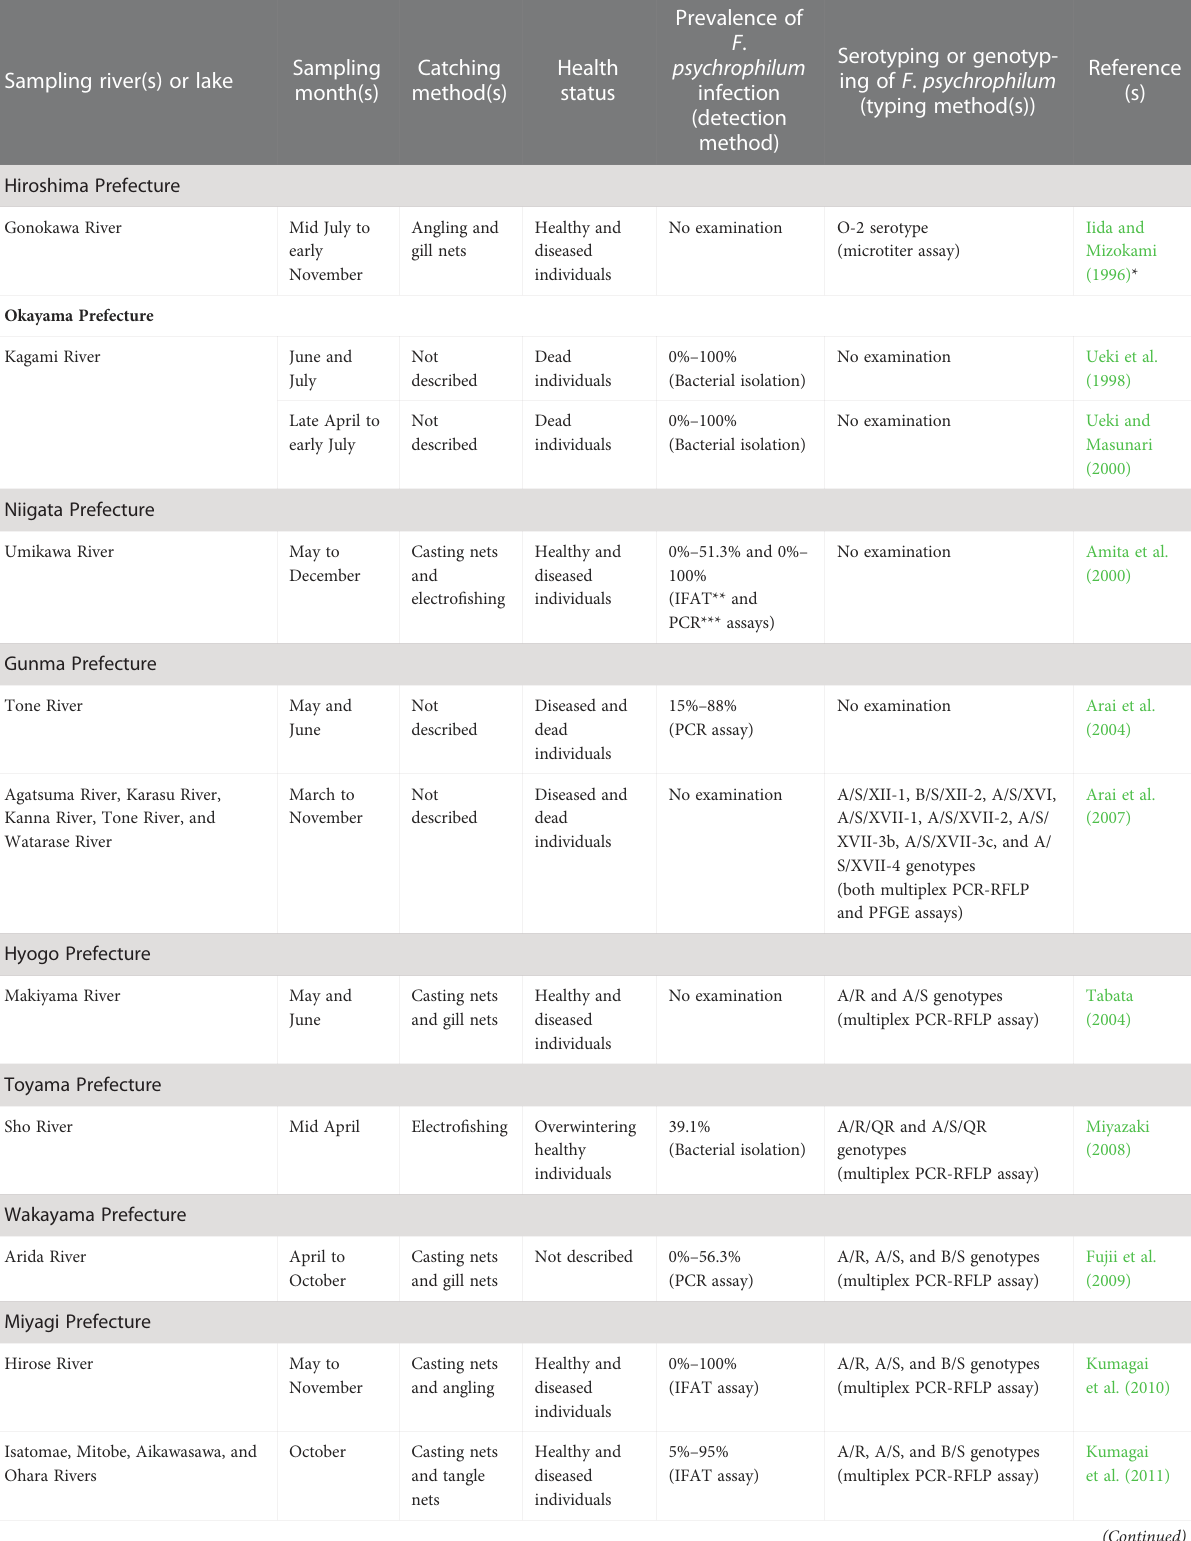
TABLE 1 Summary of the studies investigating the distribution of F . psychrophilum in ayu populations in Japanese rivers and Lake Biwa.